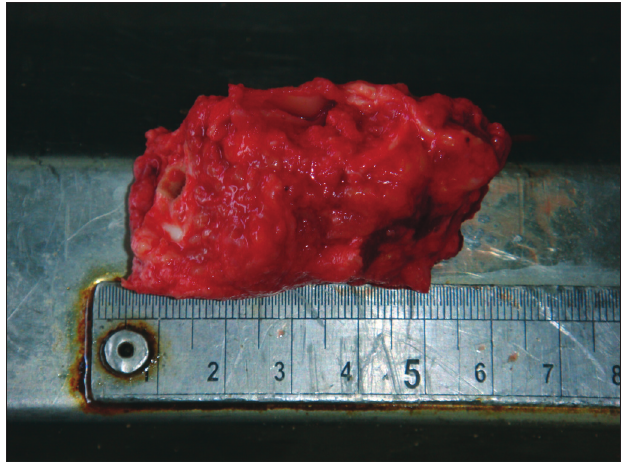
Figura 2. Aspecto da peça após sua obtenção.